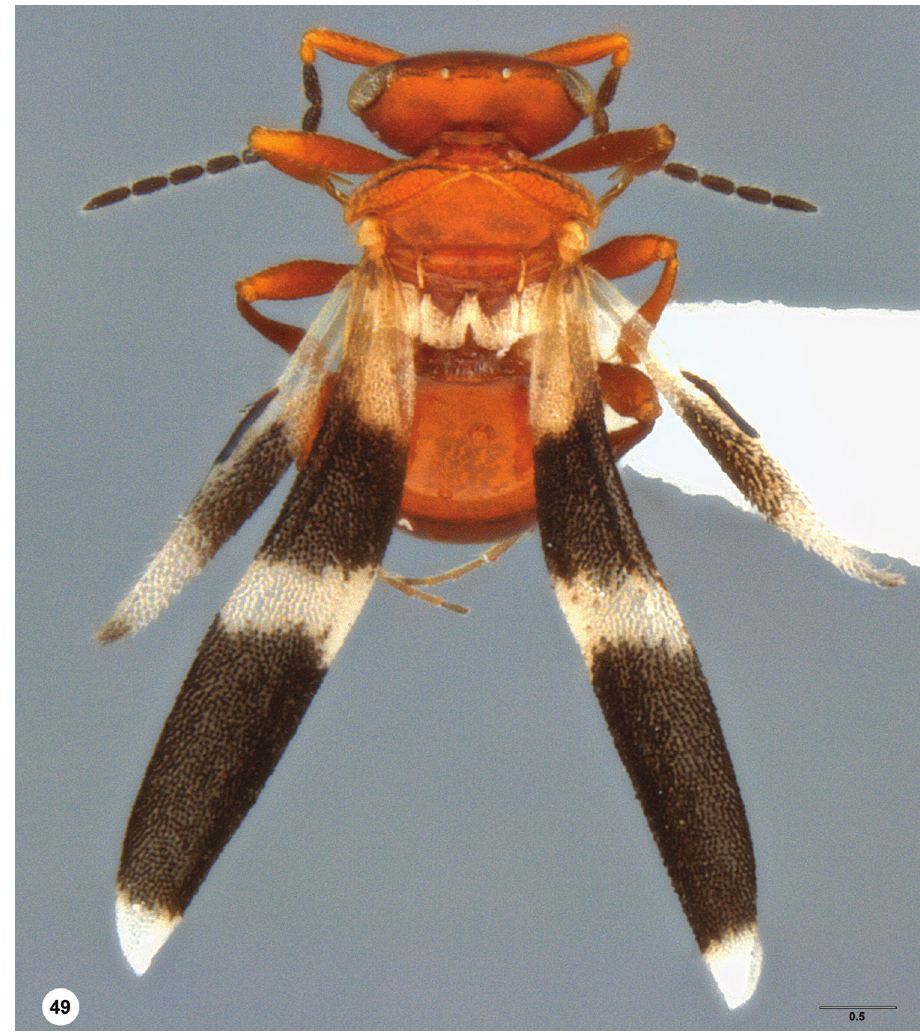
Figure 49. Pulchrisolia sanbornei , male paratype (OSUC 666396) 49 head, mesosoma, metasoma, dorsal view. Scale bars in millimeters.